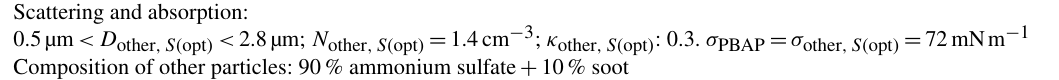
Table 2. Model sensitivity studies assume different physicochemical PBAP parameters to investigate their effect on the optical properties (Sect. 3.1), CCN activation (Sect. 3.2), and ice nucleation (Sect. 3.3). Scattering and